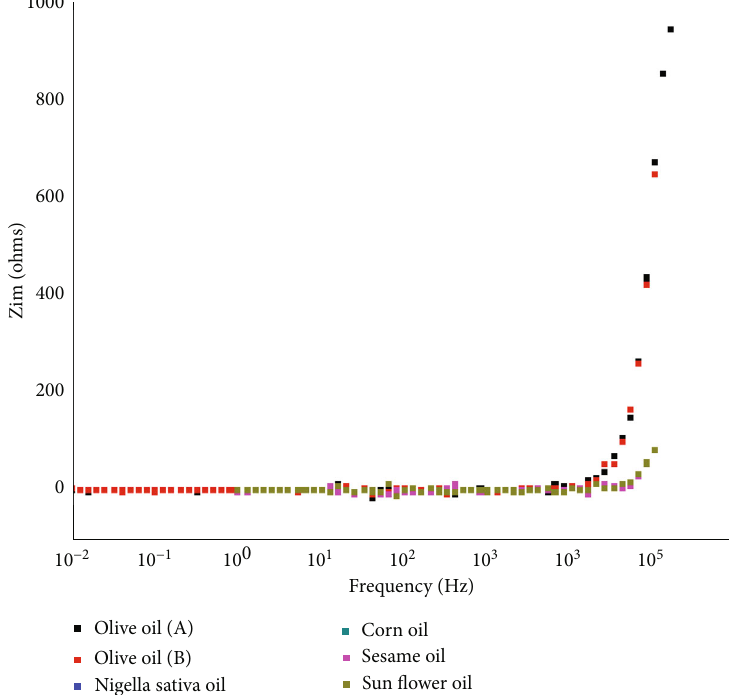
Figure 4: Frequency dependence of the imaginary part of the impedance for all